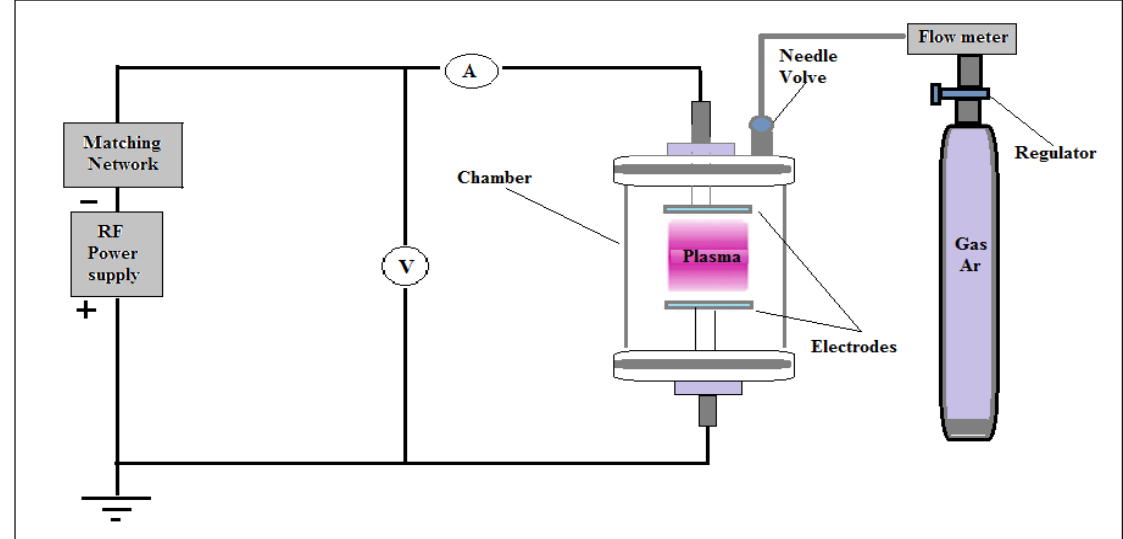
Fig.1: The CRC 600 magnetron sputtering system.